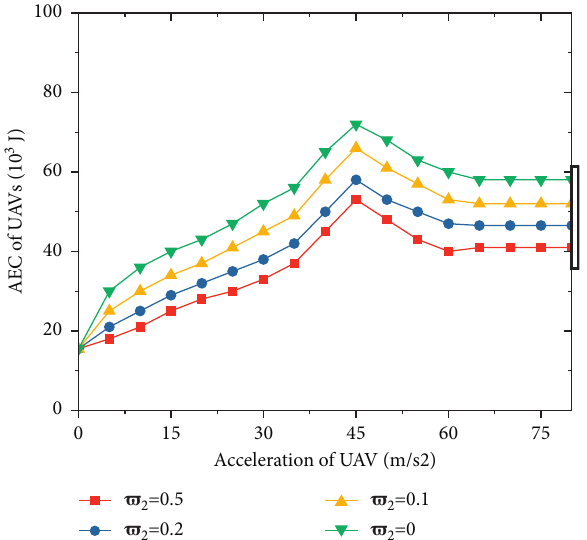
Figure 10: The AEC of UAVs versus acceleration and